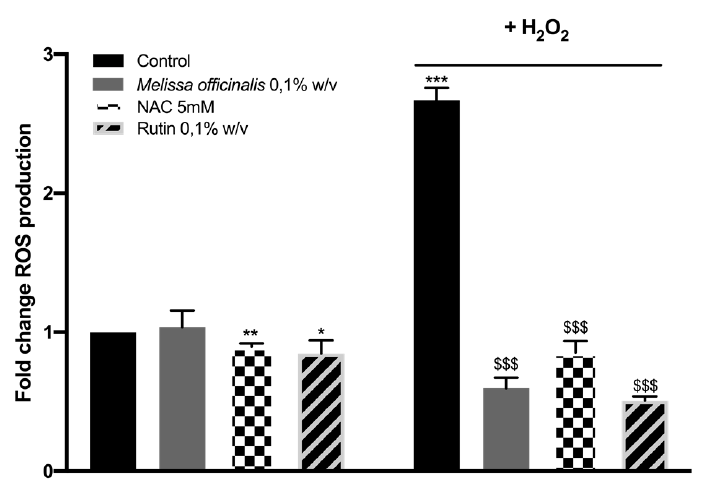
Figure 3. ROS (Radical Oxygen Species) levels in HaCaT cells after 24 h treatment with the